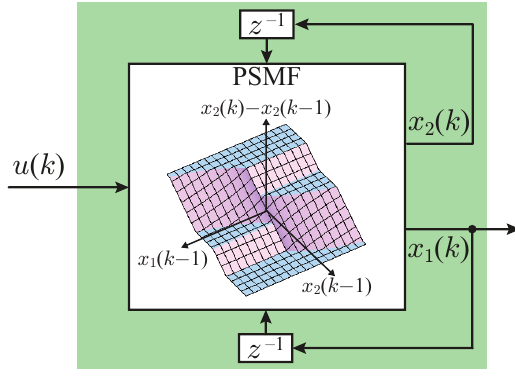
Figure 3. Block diagram of